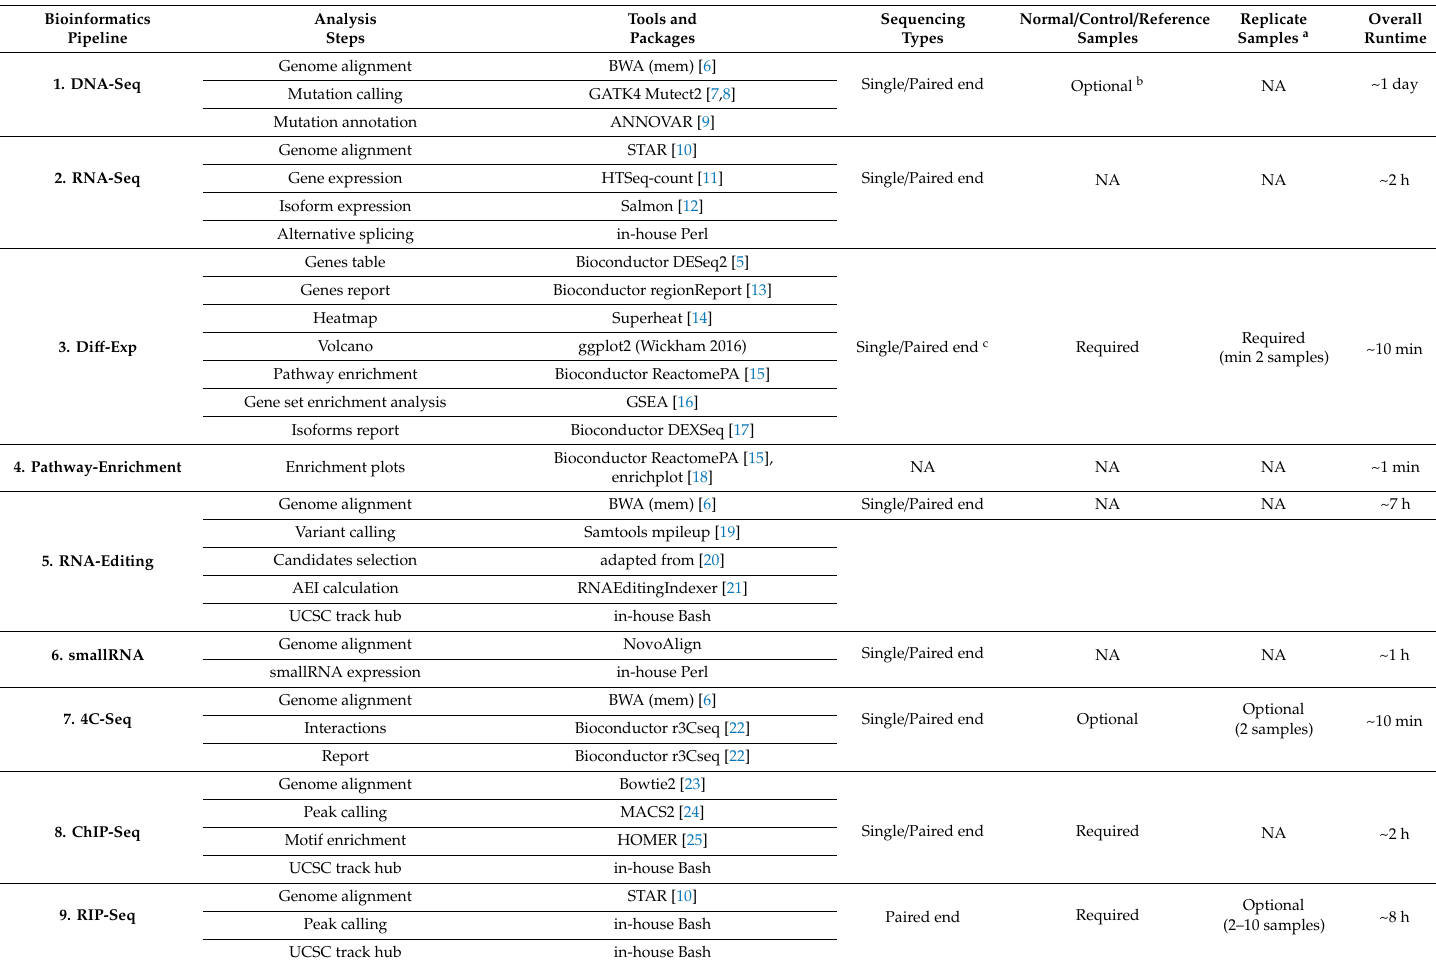
Table 1. Bioinformatics pipelines implemented on CSI NGS